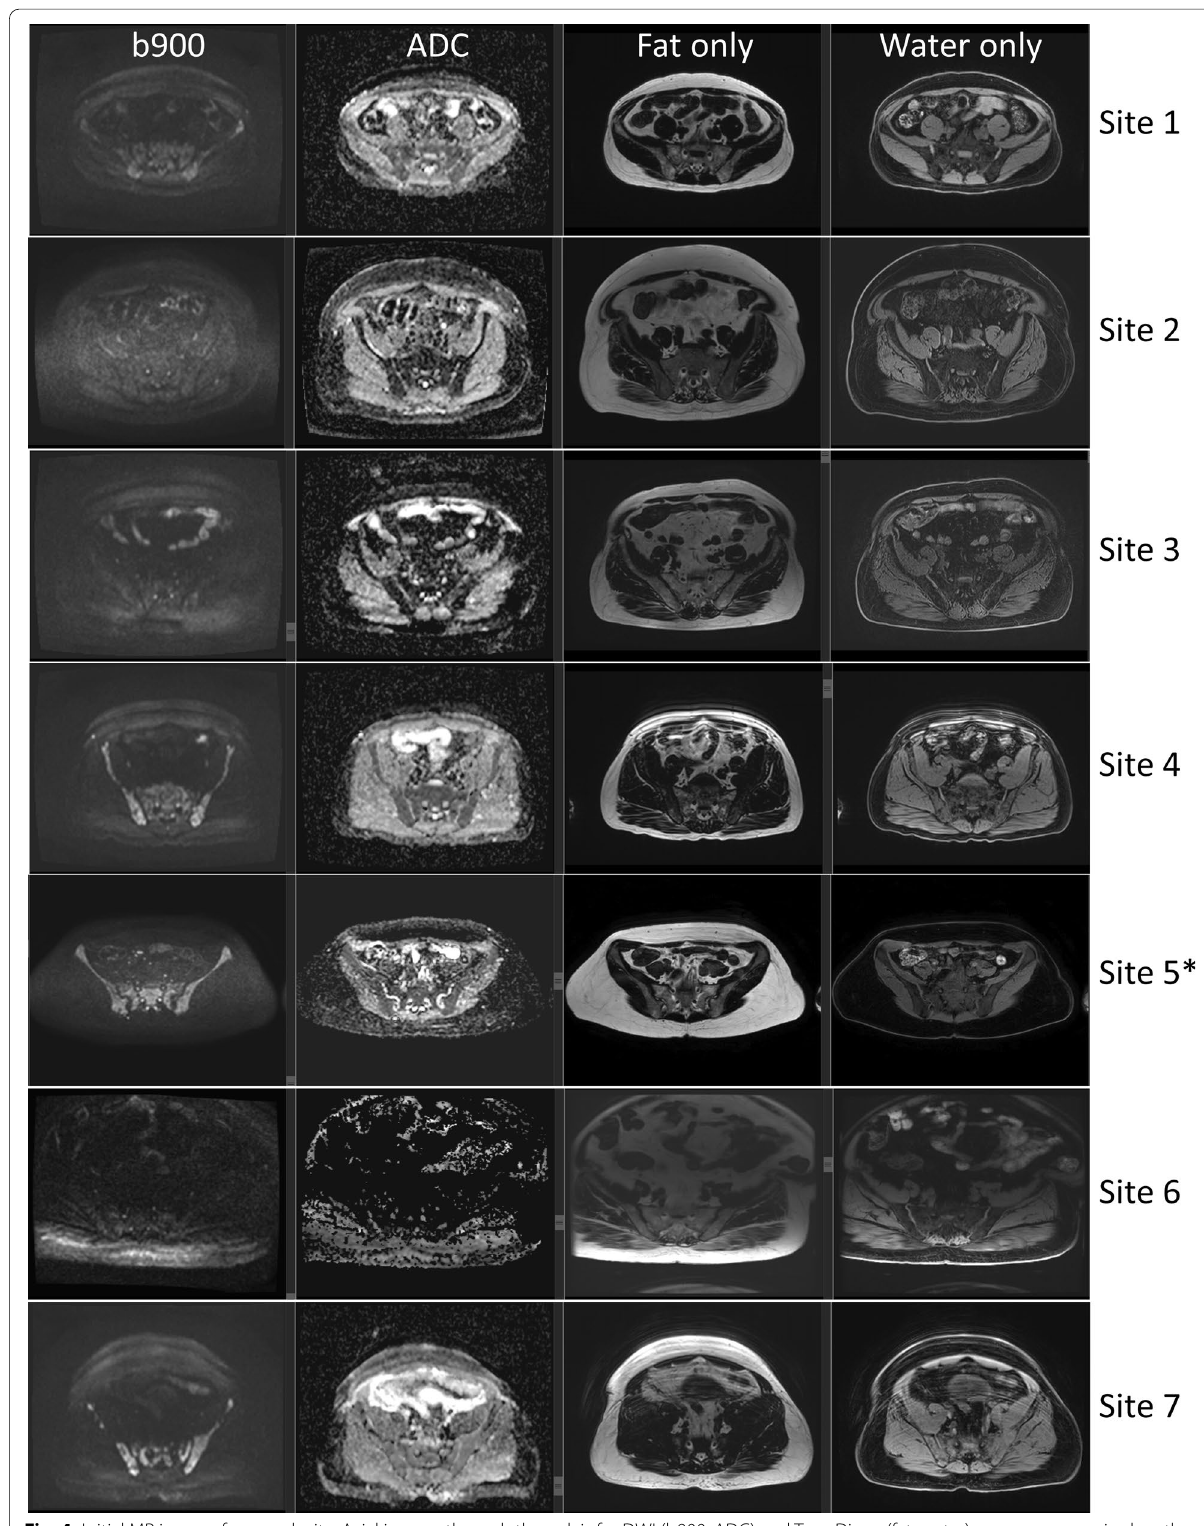
Fig. 4 Initial MR images from each site. Axial images through the pelvis for DWI (b900, ADC) and T 1 ‑w Dixon (fat, water) sequences acquired on the first datasets (9 patients and 2 volunteers) from each site; lines correspond to scanner information listed in Table 1. No data are presented for site 8 as data were unavailable (incomplete). Volunteer data are marked by the *